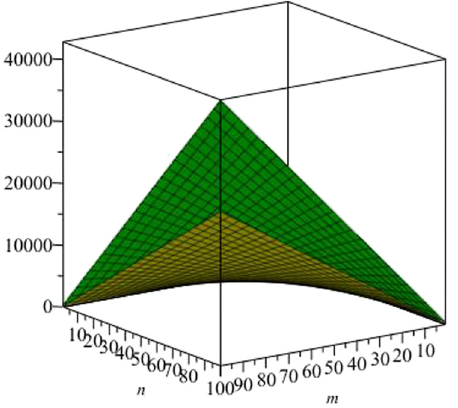
Figure 4: Comparison of modi fi ed K - Banhatti B m 1 and modi fi ed K - Banhatti B m 2 indices.